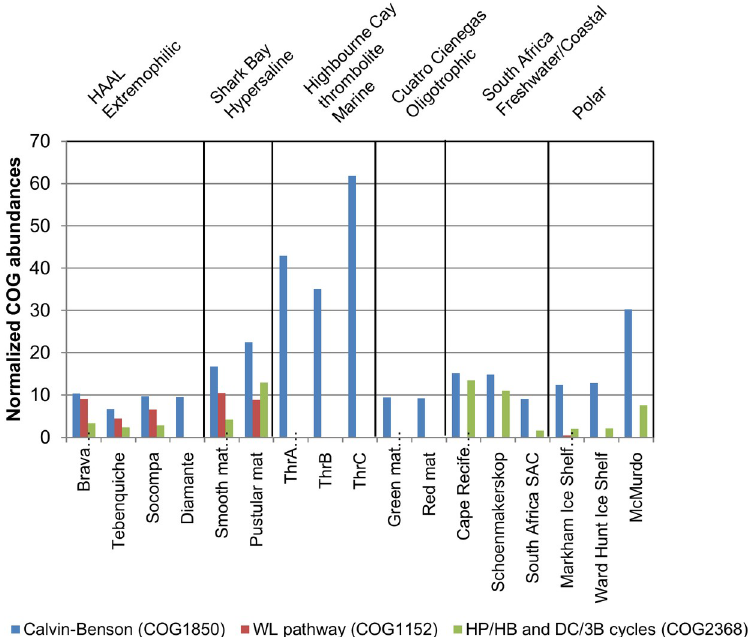
Fig 4. COG markers for carbon fixation in different metagenomes. Abundance and taxonomic affiliation of COG markers for different carbon fixation pathways were obtained from MG-RAST. Data for Brava and Tebenquiche is compared to several microbial mats and